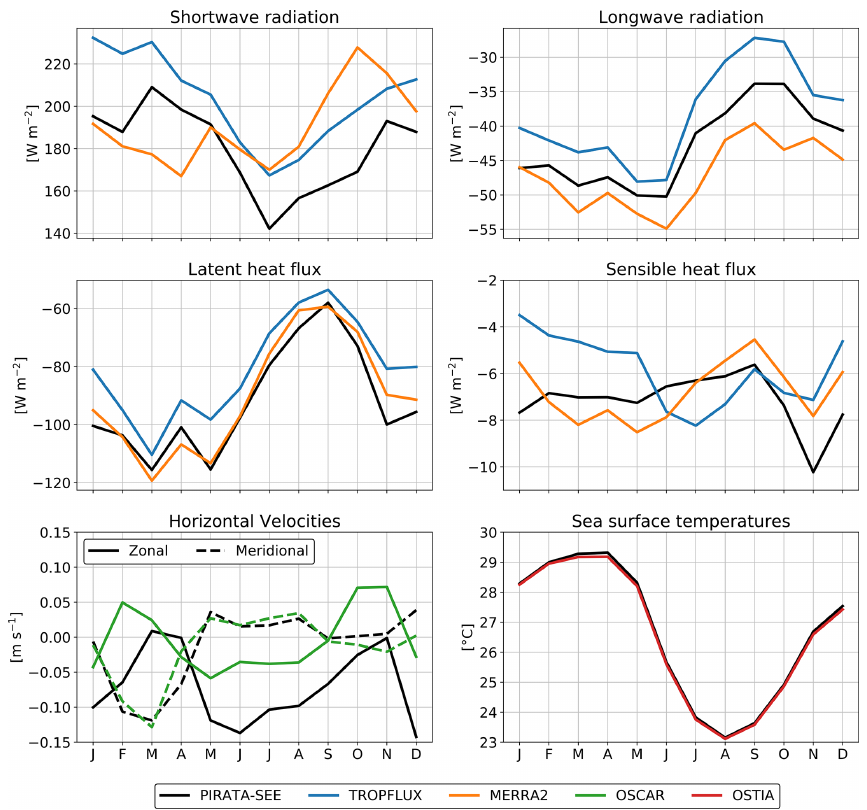
Figure A2. Seasonal cycle of variables (see titles of panels) used in the ML heat budget at 6 ◦ S, 8 ◦ E calculated from in situ data collected at the PIRATA-SEE mooring (black line) and from satellite and reanalysis data (colours, see legend). The seasonal cycle from the satellite data is derived from the time period when PIRATA-SEE data are available.